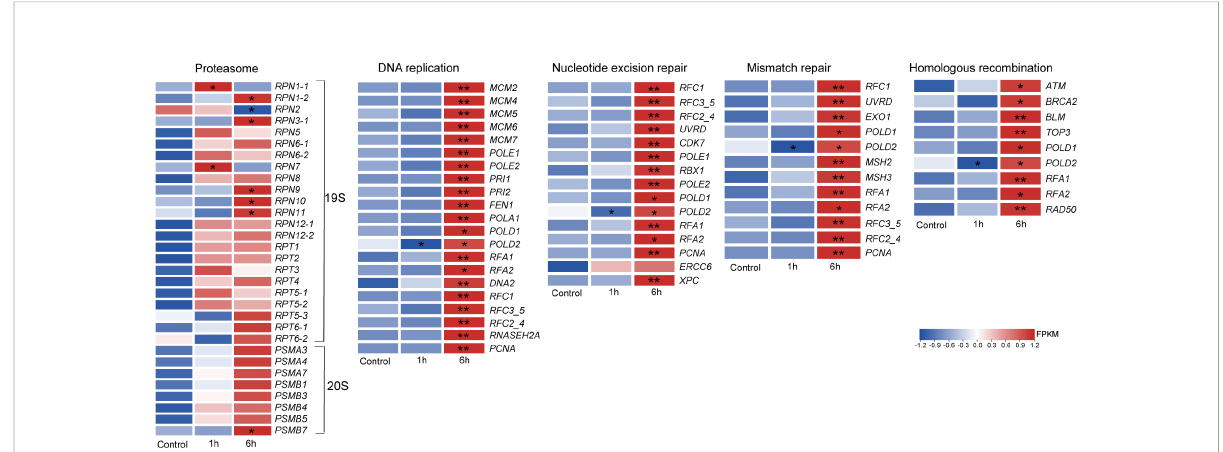
FIGURE 6 Differential expression patterns of repair systems in Neoporphyra haitanensis. The thalli were treated with 100 m M abscisic acid for 1 or 6 hours. The heatmap reveals the normalized FPKM values of transcripts (n = 3). *P <0.05, **P <0.01 when compared to control